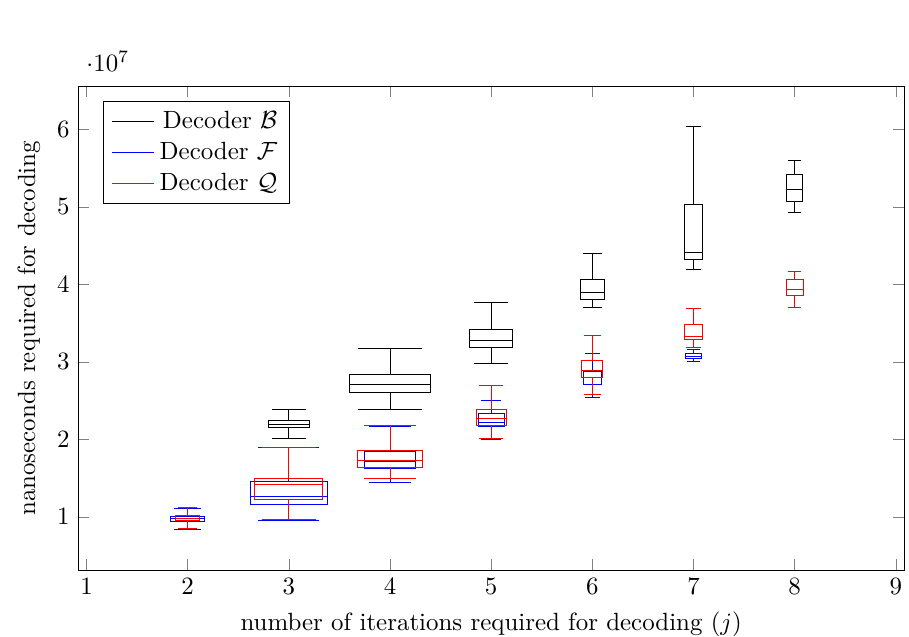
Figure 6: Box plots showing the measurement distribution of the number of nanoseconds (y-axis) for decoder B , F and Q to decode a single message using j number of iterations (x-axis). The middle line shows the median and the upper and lower edges of the boxes show the upper and lower quartiles, respectively. The upper and lower whiskers in turn indicate the lowest and highest measurement still within 1.5 IQR (InterQuartile Range) of the upper and lower quartiles, respectively. The width indicate the relative number